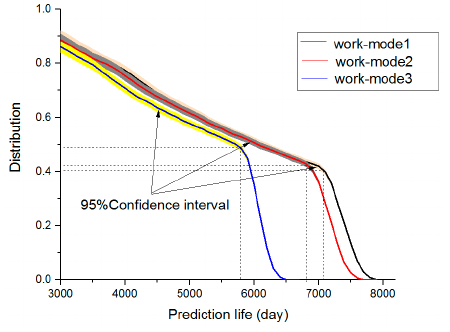
Figure 21. Life distribution of the FS with Configuration 1 in different work modes.